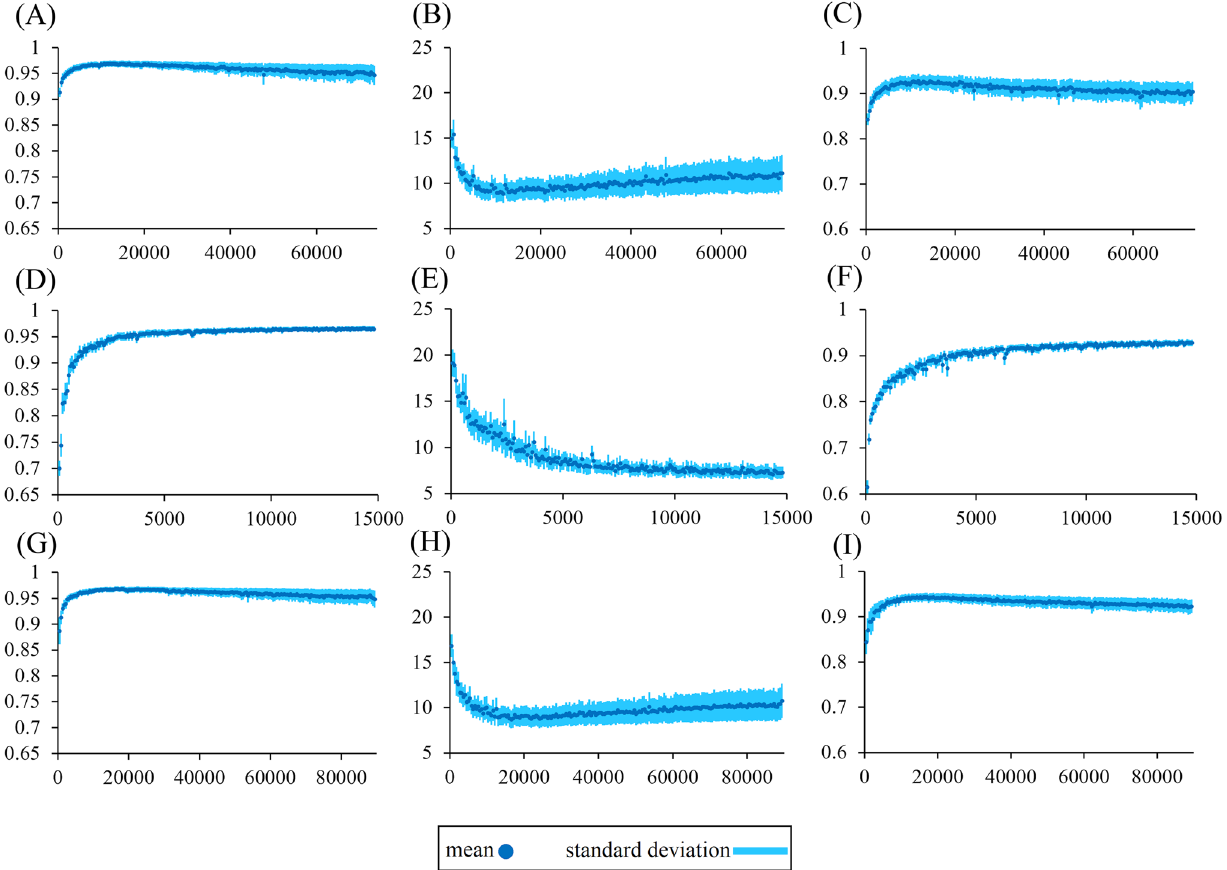
Figure 2. Similarity indices of test data over iterations. The CAD (first column), L2 norm (second column) and MSSIM (third column) of outputs from the GE-EPI-only ( A – C ), SE-EPI-only ( D – F ) and mixed ( G – I ) dataset- trained models. The mean and standard deviation are shown. The unit of the x-axis is the number of